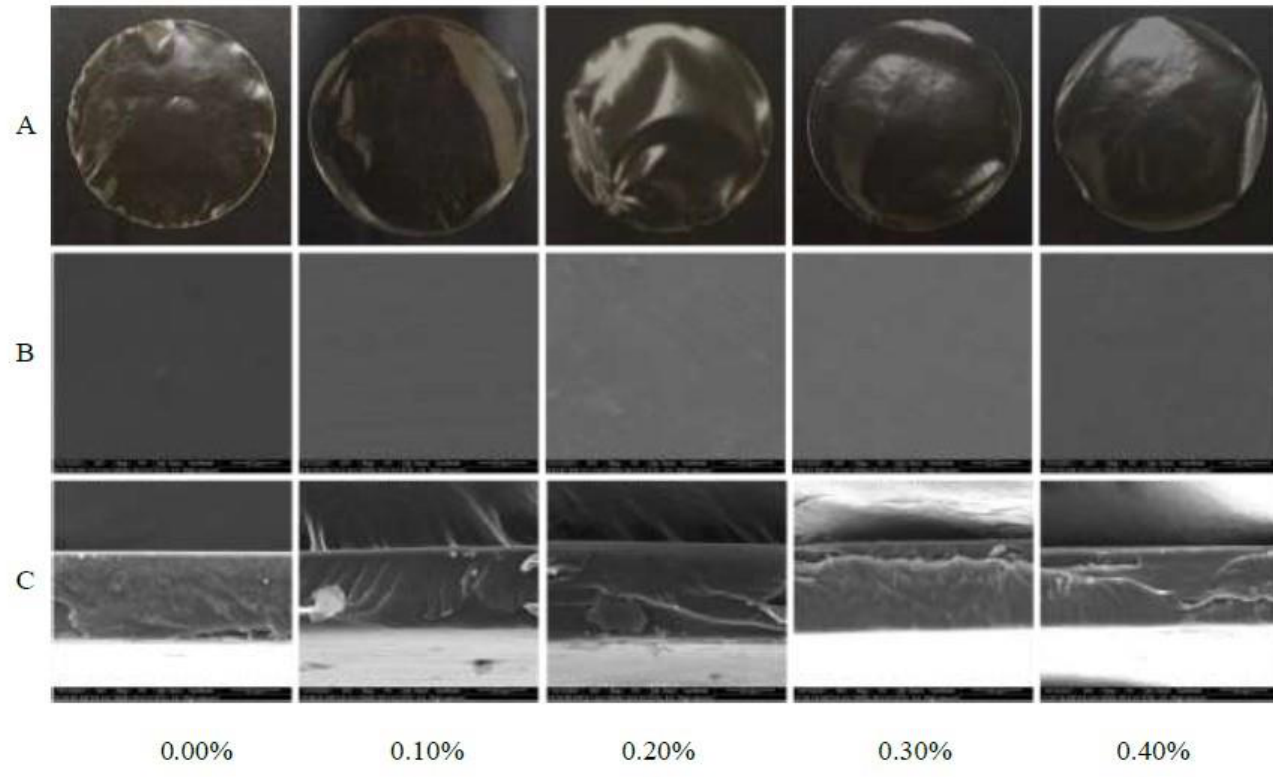
Figure 2. ( A ) Micrographs of surface ( B ) and micrographs of cross-section ( C ) of